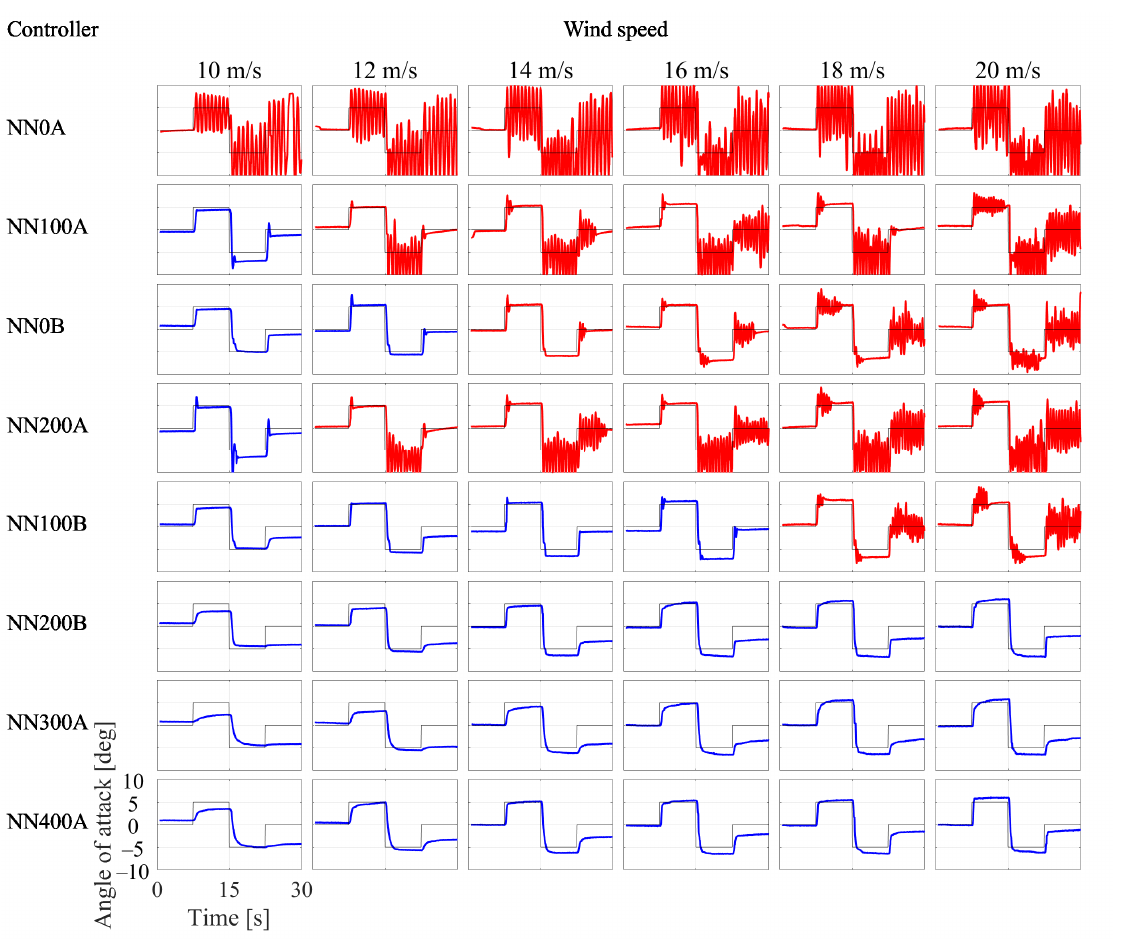
Figure 10. Experimental pitch control results. Wind speeds were from 10m/s ( left ) to 20m/s ( right ). The controllers are ordered from top to bottom in the order of theoretical performance in Figure 7. The vertical and horizontal axes correspond to the angle of attack and time, respectively. The target angle-of-attack schedules are shown with black lines. Red plots indicate the results where fluctuating behaviour was